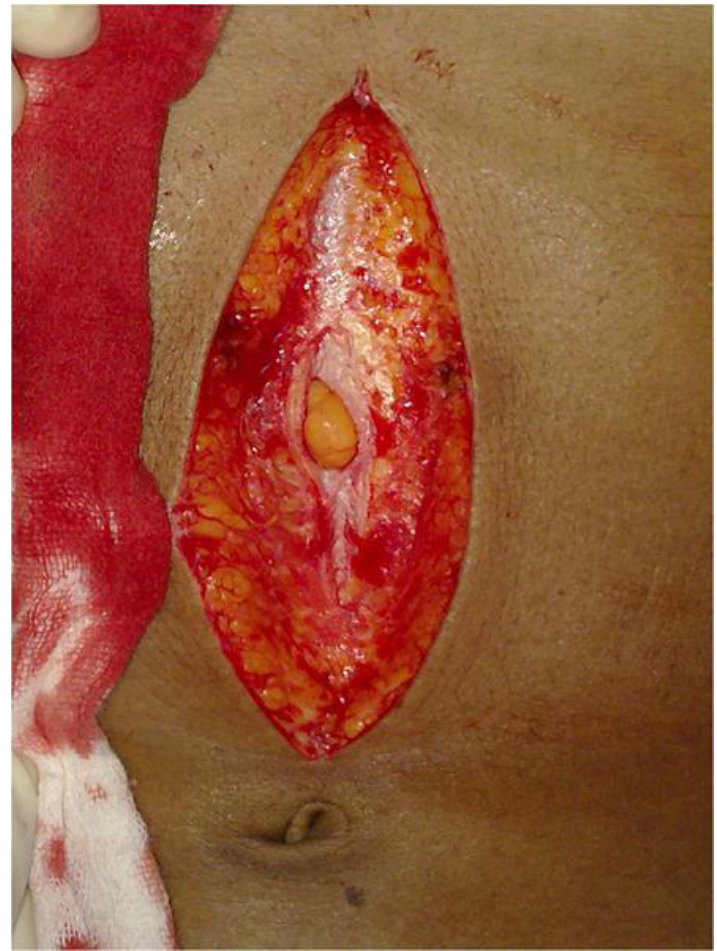
Figure 2. Normal abdominal surgical approach releasing skin tension following incision [8].